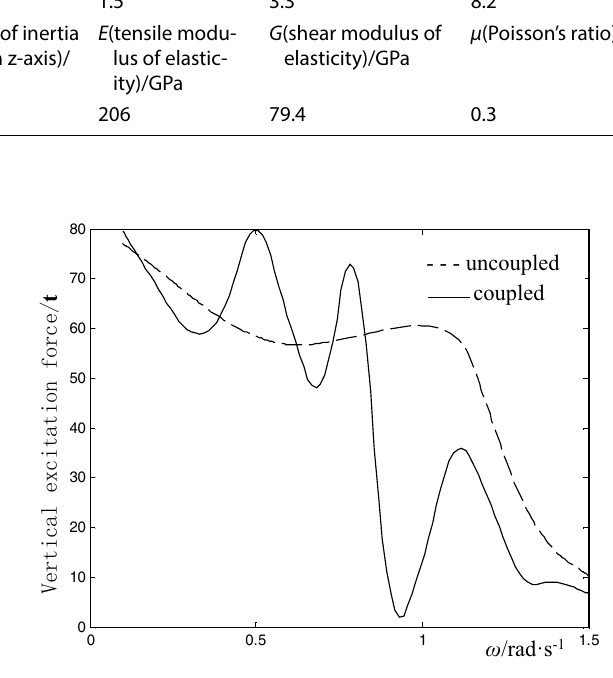
Fig. 7 Influence of wave frequency on the vertical force for the fifth pontoon ( 𝛽 = 0 ◦ )